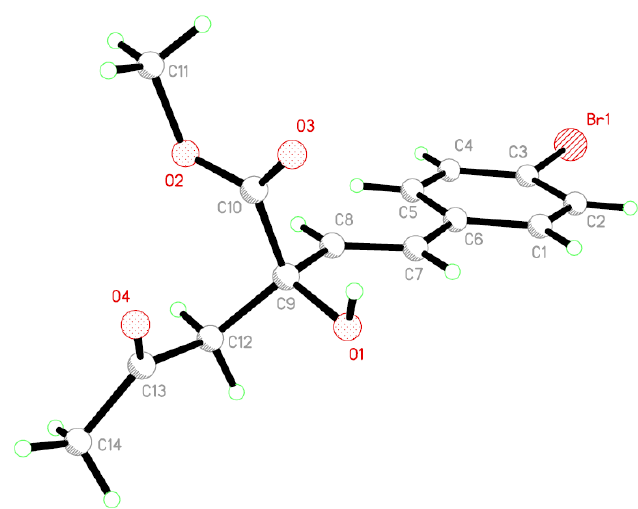
Figure 2. X-ray crystal structure of 4f